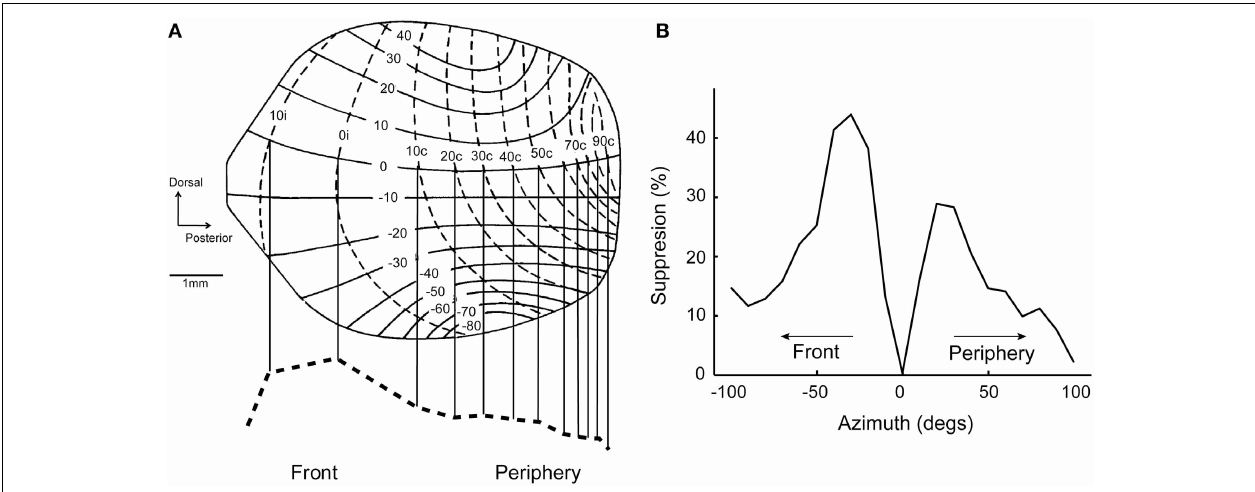
FIGURE 4 | Topography predicts population bias in surround suppression. (A) Map of auditory space in OT modified from Knudsen (1982). Frontal space ( ± 20 ◦ ) is over-represented. Bottom, dashed line shows the estimated distribution of cells across the nucleus at zero elevation. (B) Surround suppression for a neuron